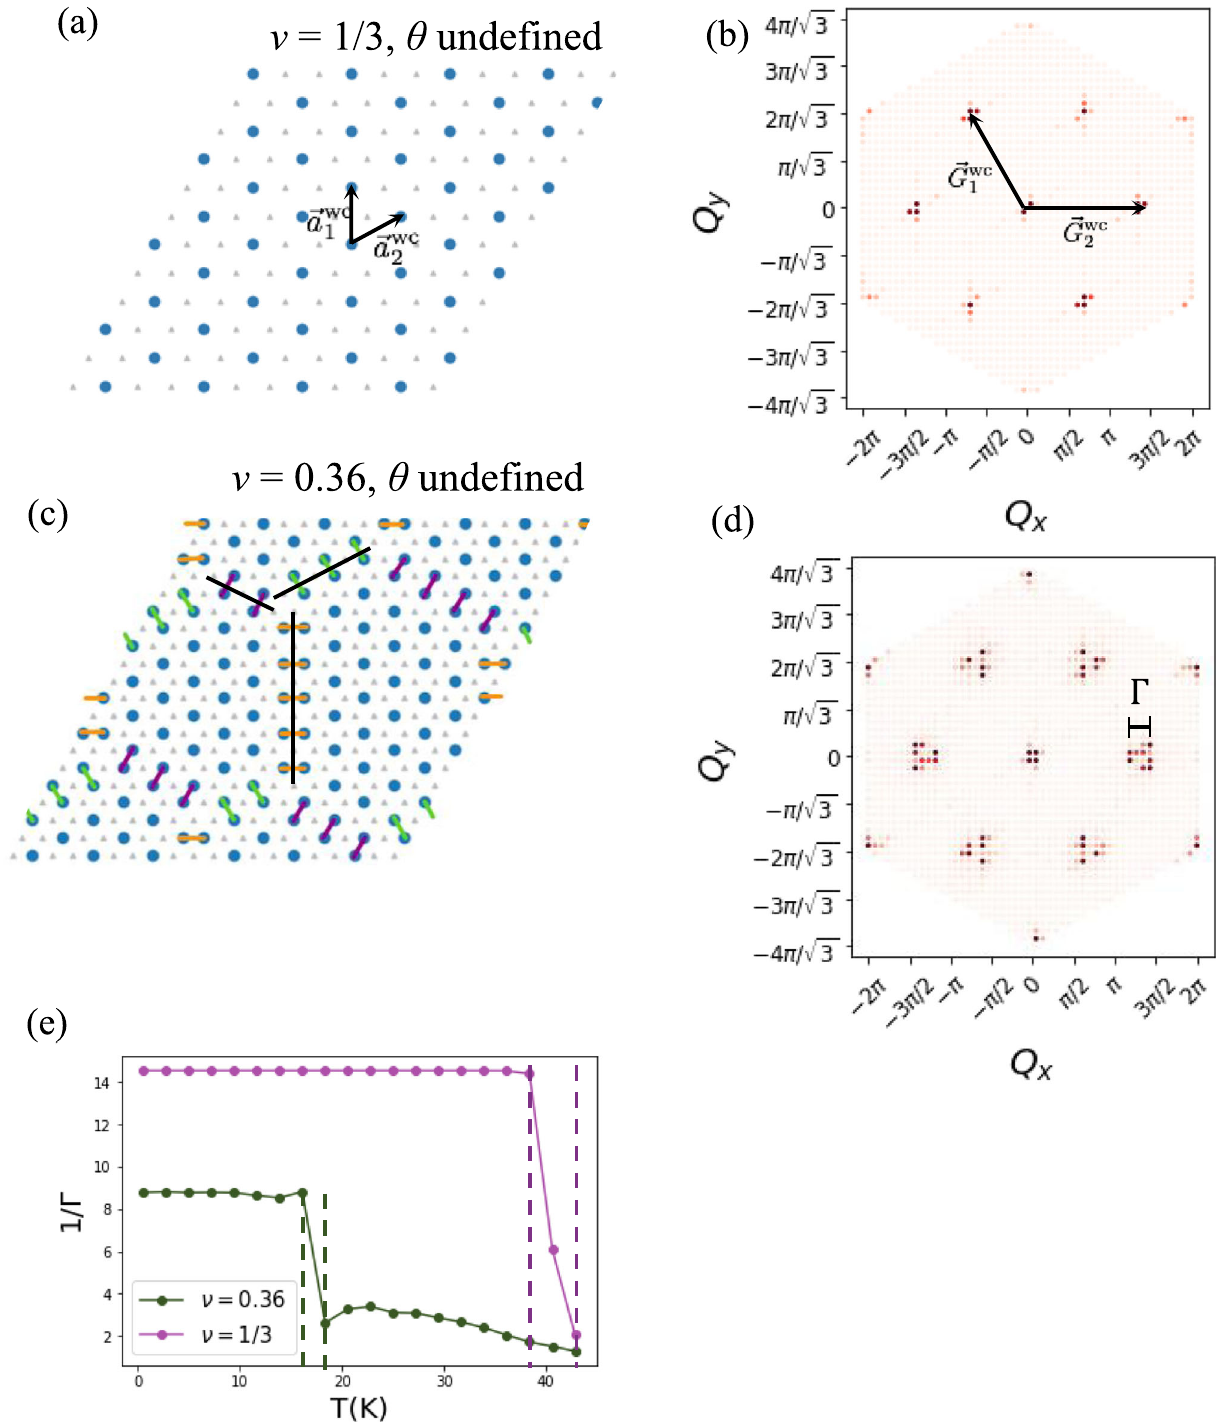
Fig. 2 | Isotropic states. a Generalized Wigner crystal at ν =1/3 particles per Moiré site for an ℓ =12system obtainedby Monte Carlo. The system isisotropic and thus theorientationofthe nematicdirector, θ , isunde fi ned. b TheMonteCarloaverage of the structure factor at ν =1/3. The structure factor exhibits peaks at the reci- procal lattice vectors of the ν =1/3 generalized Wigner crystal. c Monte Carlo equilibrated state at ν =0.36 showing the isotropic hexagonal Wigner crystal domain state. Nearest neighbor bonds are shown and color-coded according to their orientation. Domain walls (marked with black lines) between the three registries of the generalized Wigner crystal state meet at 2 π /3 angles, forming hexagonal domains. d The Monte Carlo average of the structure factor at ν =0.36,